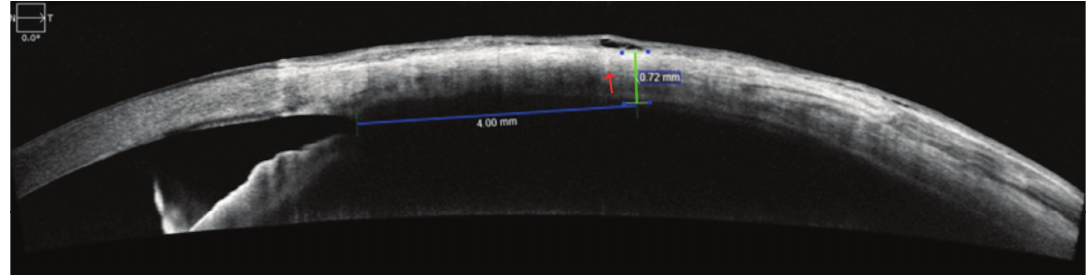
Figure 2. Anterior segment OCT demonstrating changes of conjunctiva after multiple injections. Episcleral cystoid cavity is displayed ( green arrow) corresponding well with the injection site marked by the injection tract ( red